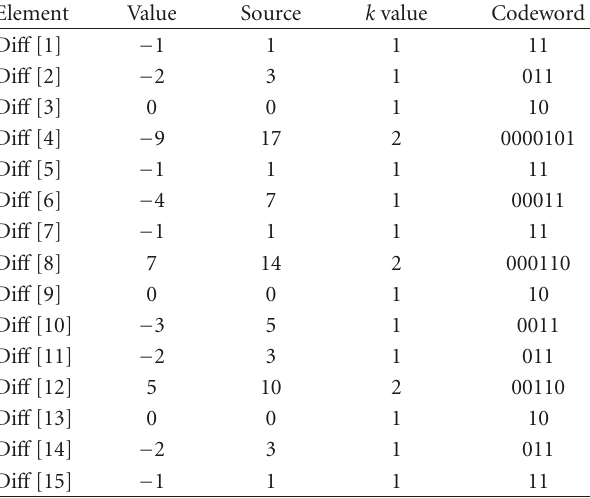
Table 1: The Golomb-Rice Codewords of the 4 × 4 Block Shown in Figure